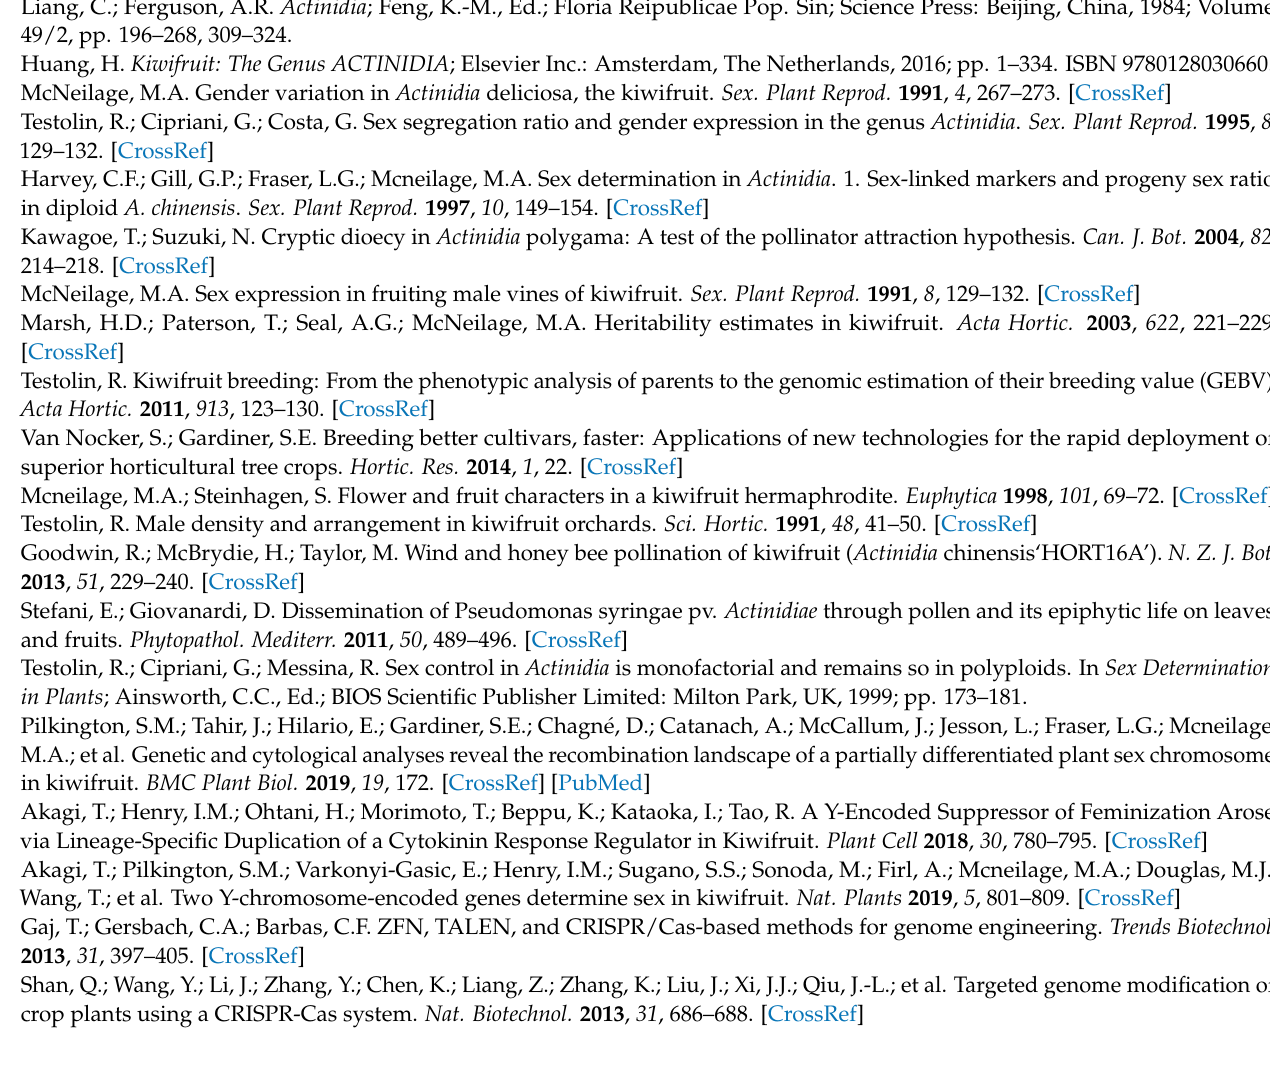
Table S1: Primer sequences used in this study. Supplementary Table S2: Composition of media used in this